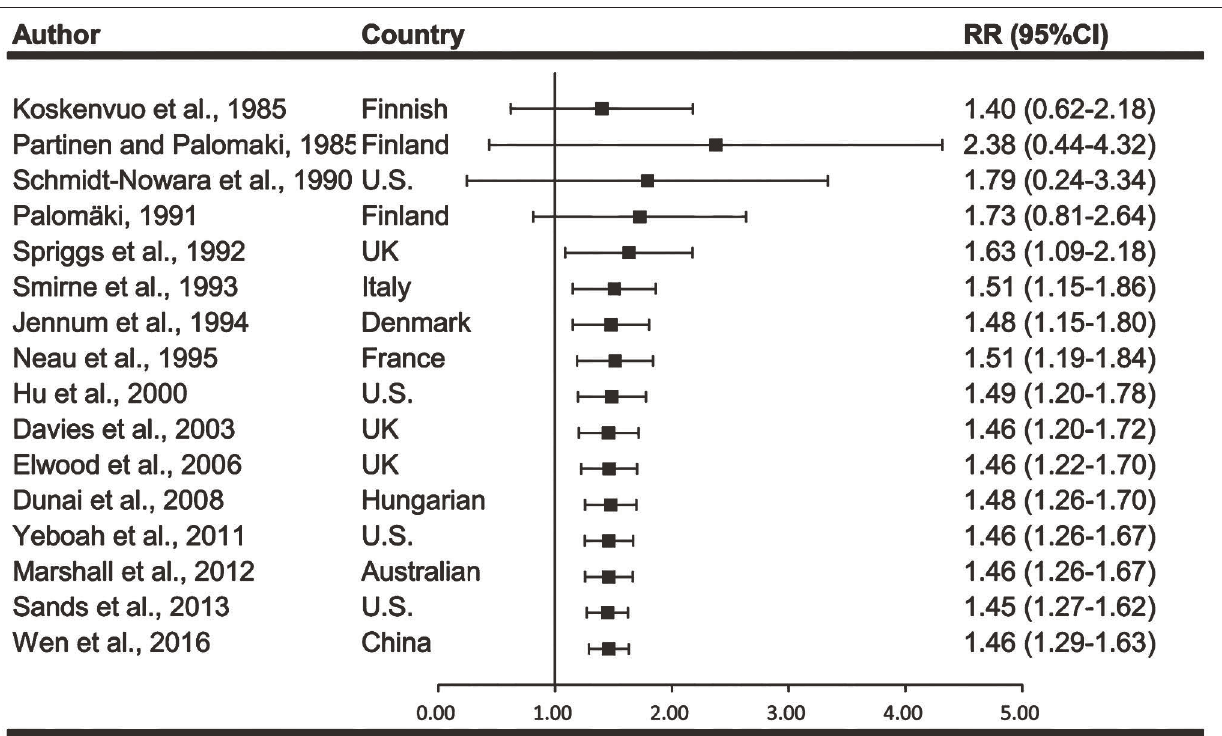
Frontiers in Neurology |